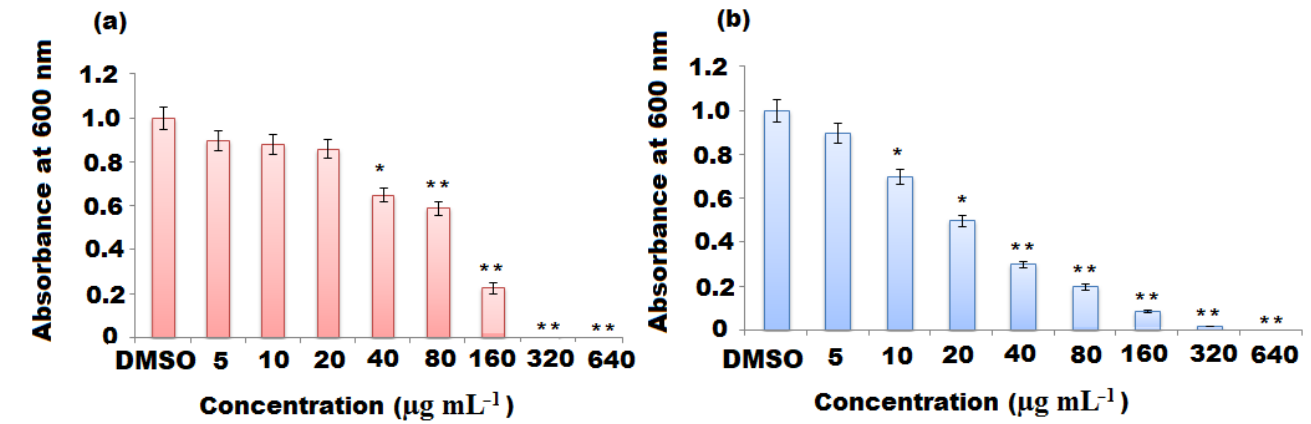
Figure 8. Minimum bactericidal concentration (µg mL − 1 ) of the green synthesized ZnONPs using oat biomass against ( a ) P . aeruoginosa and ( b ) E. coli . Results are expressed as mean ± SD after triplicate studies. The * and ** in the bars represent S.E. (* p < 0.05, ** p < 0.01)